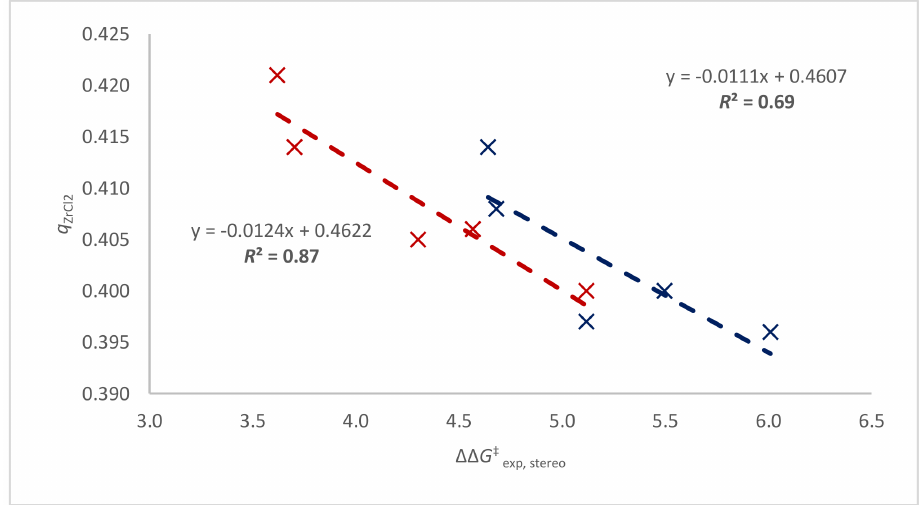
Figure 2. Correlation of experimentally observed stereoselectivity ( ∆∆ G ‡ exp, stereo ) at 100 ◦ C and electrophilicity of catalyst dichloride precursor (as measured by q MCl2 ). Red trace hafnocenes Hf-1 to Hf-5 , blue trace zirconocenes Zr-1 to Zr-5